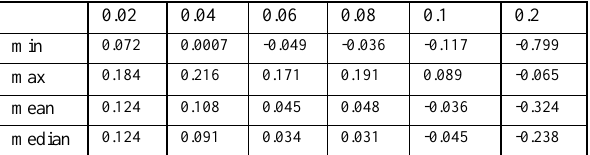
Table 4: Statistical analysis for the right edges in the six test cases of raster cell dimension